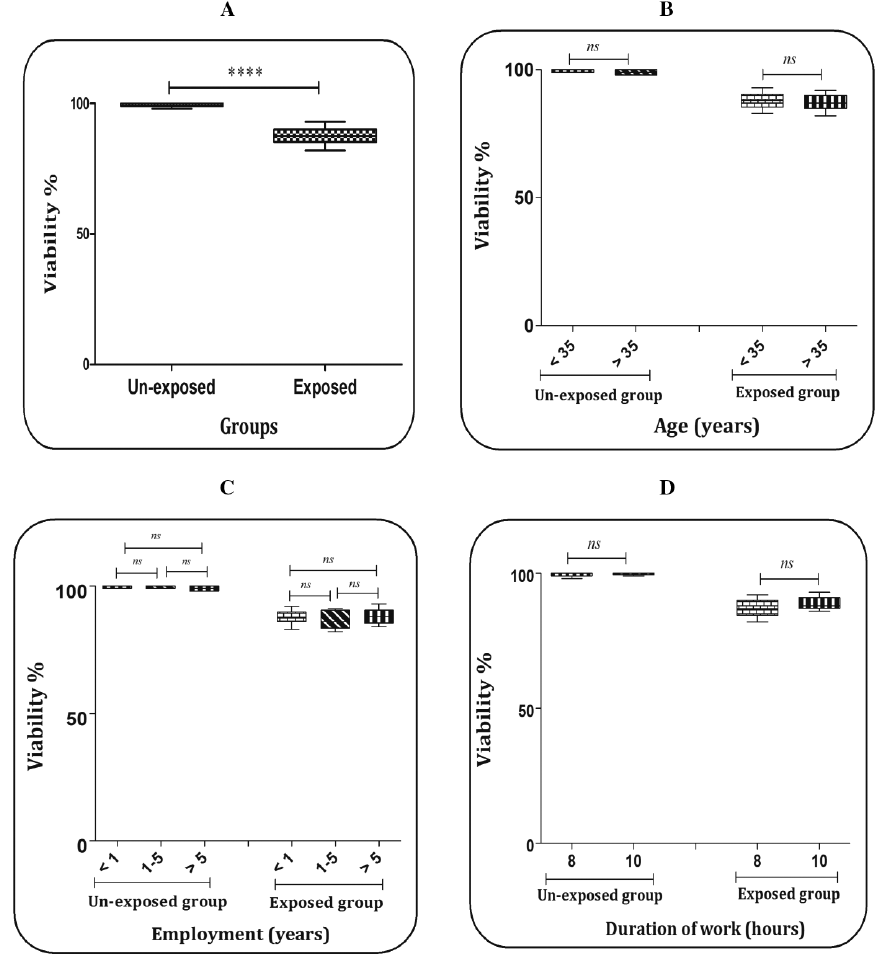
Figure 1: The cell viability assay. (a) Comparison between exposure and non-exposure groups. (b) Comparison between the exposed and unexposed groups based on age (year). (c) Comparison between the exposed and unexposed groups based on employment (year). (d) Comparison between the exposed and unexposed groups based on duration of work (hours). Data are presented as mean ± SD (n = 20). **** P <